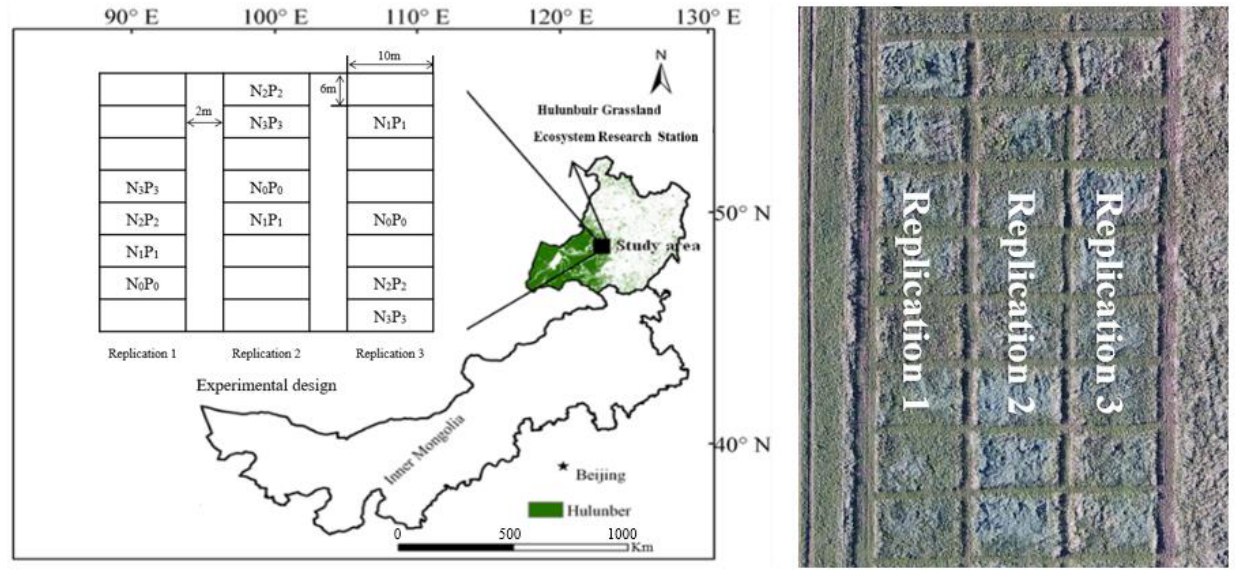
Figure 2. Study area geographic location and the experimental layout.